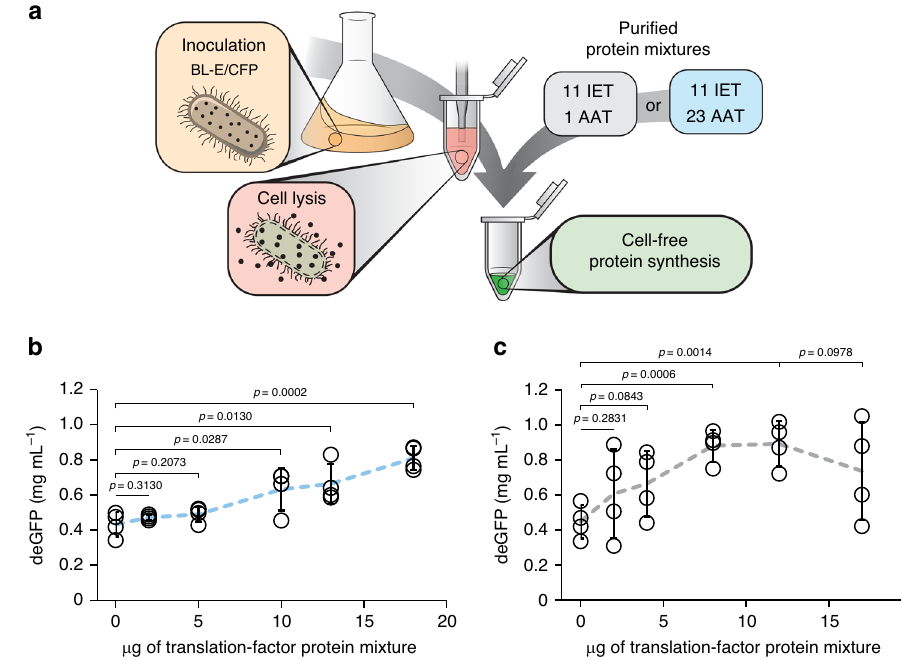
Fig. 2 Supplemented translation machinery partially enhances protein expression. a Graphical representation of the supplementation of puri fi ed translation factors to CFPS reactions assembled using BL-E WCE and BL-CFP WCE . Two different mixtures of puri fi ed translation machinery were produced, one with 11 IET (initiation, elongation, termination factors) and 1 AAT (aminoacyl-tRNA transferases) and the other with 11 IET and 23 AAT proteins. b Expression yield of BL-E WCE increases proportionally with the supplementation of puri fi ed translation machinery. The addition of 10 and 13 μ g of puri fi ed translation factors to a 10 μ L CFPS reaction increases protein yield by ~1.5-fold. Supplementation of up to 18 μ g of puri fi ed translation factors increases protein yield by approximately twofold. Reaction assembly, puri fi ed protein supplementation, and incubation conditions are described in “ Methods, Sections M3 and M6 ” . Data are presented as mean values and error bars represent s.d. ( n = 4 independent experiments). Standard two-tail t -test. c Expression yield of BL-CFP WCE increases proportionally with the supplementation of puri fi ed translation machinery. The addition of 8 and 12 μ g of puri fi ed translation factors to a 10 μ L CFPS reaction increases protein yield by approximately twofold. Supplementation of up to 17 μ g of puri fi ed protein does not result in any further increase. Reaction assembly, puri fi ed protein supplementation, and incubation conditions are described in “ Methods, Sections M3 and M6 ” . Data are presented as mean values and error bars represent s.d. ( n = 4 independent experiments). Standard two-tail t -test. Source data for b , c are provided as a Source Data fi